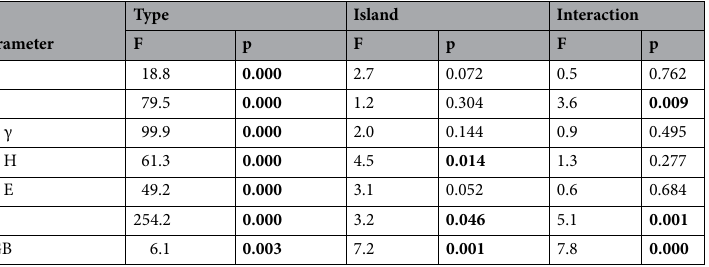
Table 5. Comparison of structural diversity at 90 forests in the Azores, from three islands (Pico, São Miguel, and Terceira) and three forest types (Exotic Woodland, Natural Forest, and Production Forest). Tree density (D, trees ha −1 ), Basal area (BA, m 2 ), BA γ (number of taxa contributing to the BA, i.e., those with a diameter at breast height above 2.5 cm), Shannon diversity based on BA (BA H), Evenness based on BA (BA E), aboveground biomass (AGB Mg ha −1 ). Results of a two-way ANOVA. Bold indicates a significant effect (p < 0.05).